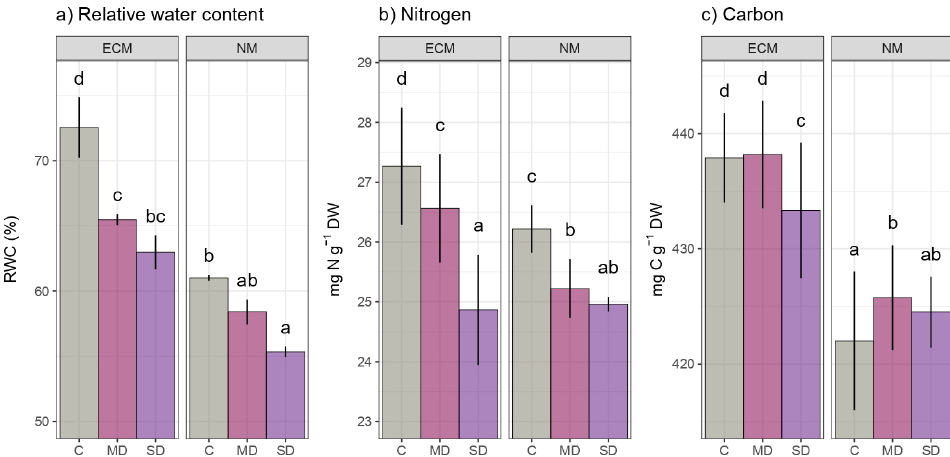
Figure 1. The effects of mycorrhization and/or drought on:( a ) Relative water content (RWC; %), ( b ) Nitrogen content (N; mg g − 1 ), and ( c ) Carbon content (C; mg g − 1 ) in leaves of Q. robur . Treatments: C-control regularly watered oak seedlings, MD-oak seedlings exposed to the mild drought that corresponds with 60% of soil water field capacity, SD- oak seedlings exposed to the severe drought that corresponds with 30% of soil water field capacity ECM-oak seedlings inoculated with ectomycorrhizal inoculum, and NM-oak seedlings not inoculated with ectomycorrhizal inoculum. Different small letters indicate significant differences across the different treatments; Tukey’s honestly significant difference (HSD) post hoc test ( p ≤ 0.05). Data represent the mean ± standard deviation (SD).